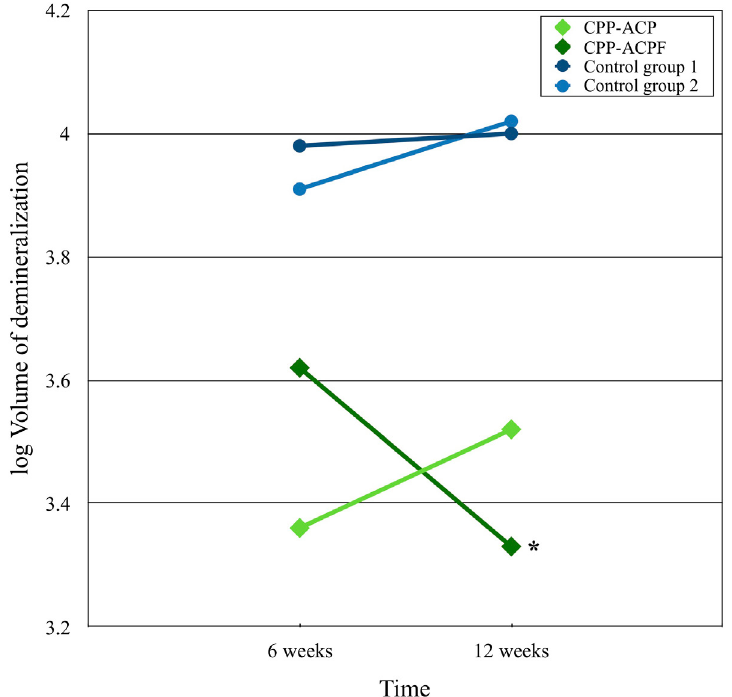
Figure 2- The effect of time and treatment on the logarithmic volume of demineralization of the two experimental and two control groups. The significant reduction of the logarithmic demineralization volume of the CPP-ACPF group from 6 to 12 weeks ( p =0.012) is indicated with an asterisk